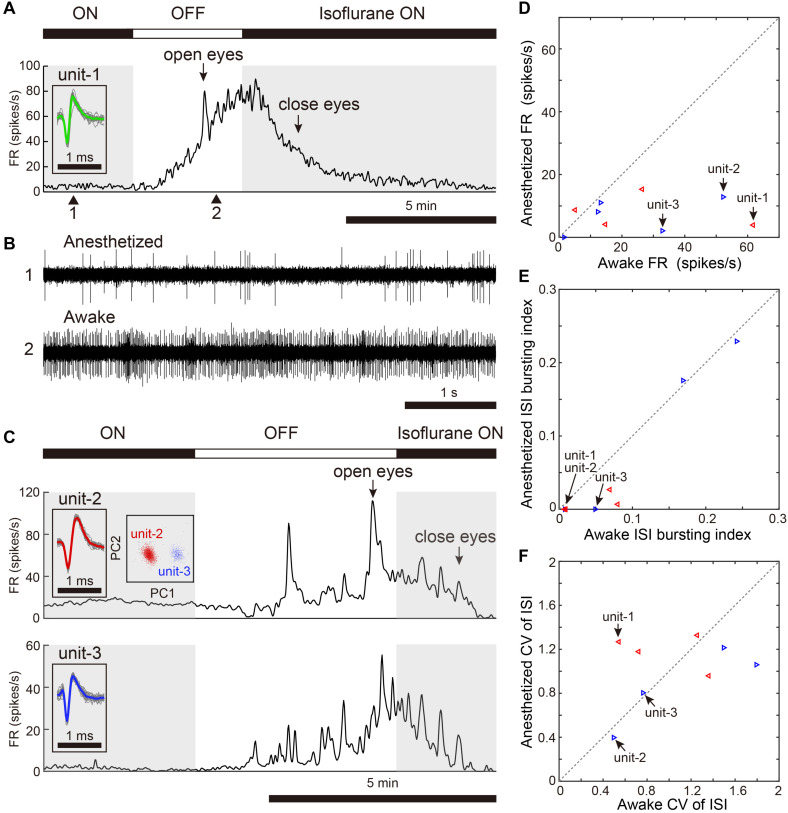
Changes in spontaneous neural activity across isoflurane-anesthetized and wake states. (A) Representative spike rate histogram of a single VTA neuron (unit-1) under isoflurane anesthesia. The top bar displays periods when isoflurane anesthesia is turned on (black) and off (white). Gray shadings denote the anesthetized period. Arrows indicate when birds opened and closed their eyes. Inset shows spike waveforms. (B) Example of raw spike traces under anesthetized (1, top) and awake (2, bottom) states. (C) Representative spike rate histogram of simultaneously recorded 2 single SNc neurons (unit-2, -3) under isoflurane anesthesia. Insets show spike waveforms and spike clusters. (D) Comparison of mean spontaneous firing rates between anesthetized and awake (unanesthetized) states, n = 9 neurons, 2 birds. (E) Comparison of ISI-based bursting index, proportion of ISIs <6 ms, between anesthetized and awake states. (F) Comparison of CV (coefficient of variation) of ISI between anesthetized and awake states. The data shown in (A,C) (unit-1-3) are indicated by arrows in the scatter diagram (D–F). Same symbols (color/shape) in (D–F) are data from the same bird and correspond to the histological data in Figure 1E.